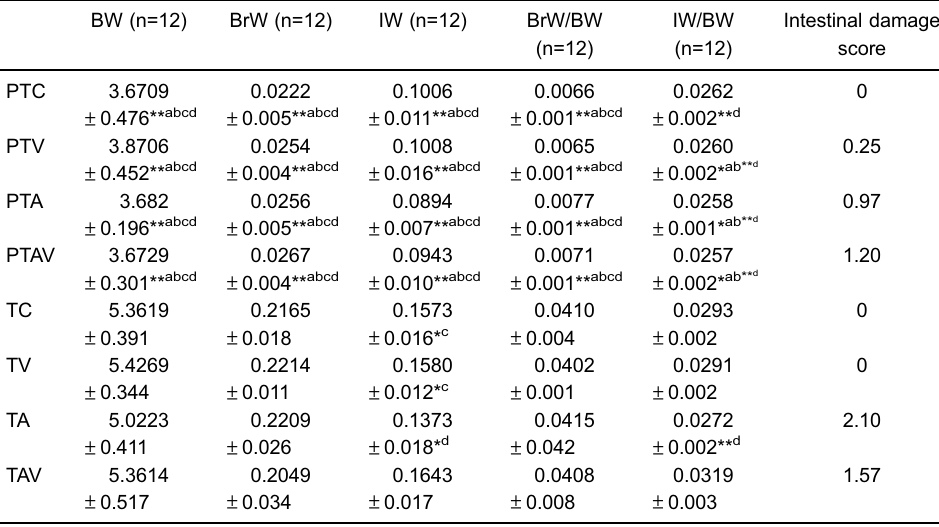
Table 1. Body weight (BW), brain weight (BrW), intestinal weight (IW), Br/BW ratio, IW/BW ratio, and mean score for intestinal damage for each